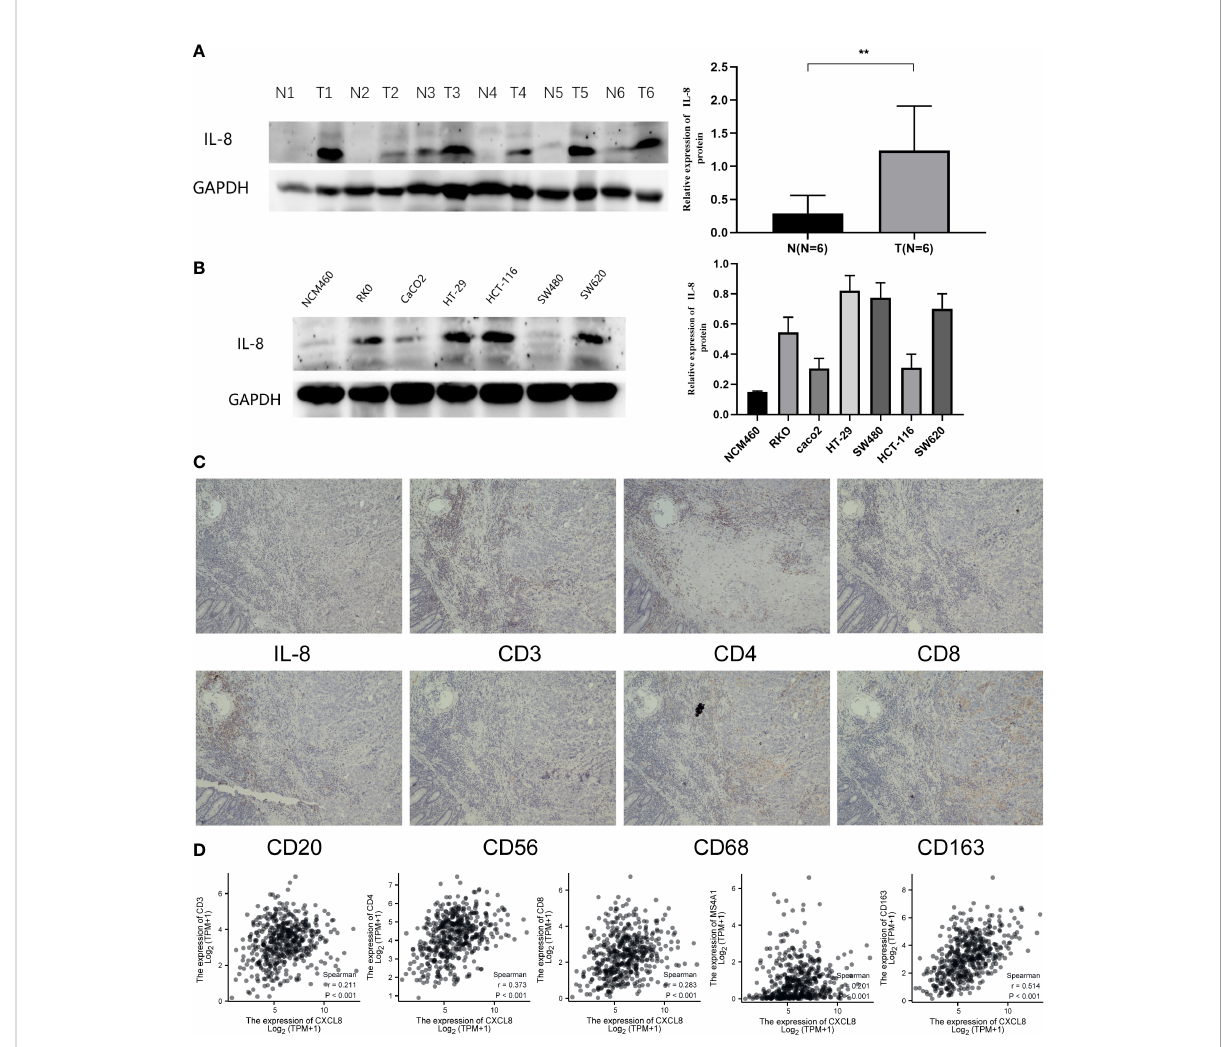
FIGURE 9 Expression of CXCL8 in COAD and the role of CXCL8 in immune in fi ltration. (A) WB revealed that CXCL8 expression was higher in tumor samples than normal samples. (B) Compared with NCM460 cells, CXCL8 had a higher expression in COAD cell lines, including RKO, CaCO 2 , HT-29, HCT-116, SW480, and SW620 cells. (C) IHC of CXCL8, CD3, CD4, CD8, CD20, CD56, CD68, and CD163 in the serial section of LIHC tissues (original magni fi cation 100×). (D) CXCL8 expression was correlated with that of CD3, CD4, CD8, CD20 (MS4A1), and CD163 in COAD tissues ( p < 0.05). **p <